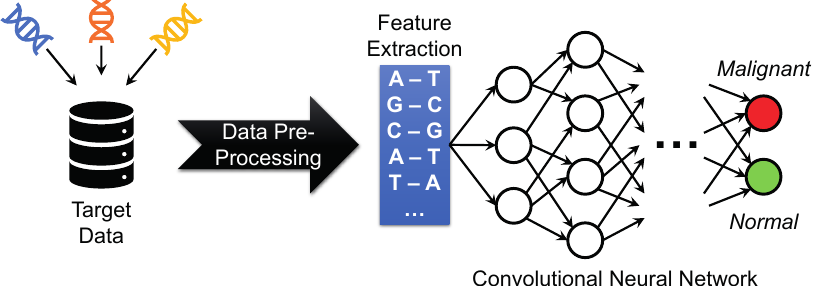
Figure 7. Application of a Convolutional Neural Network for the Classification of DNA